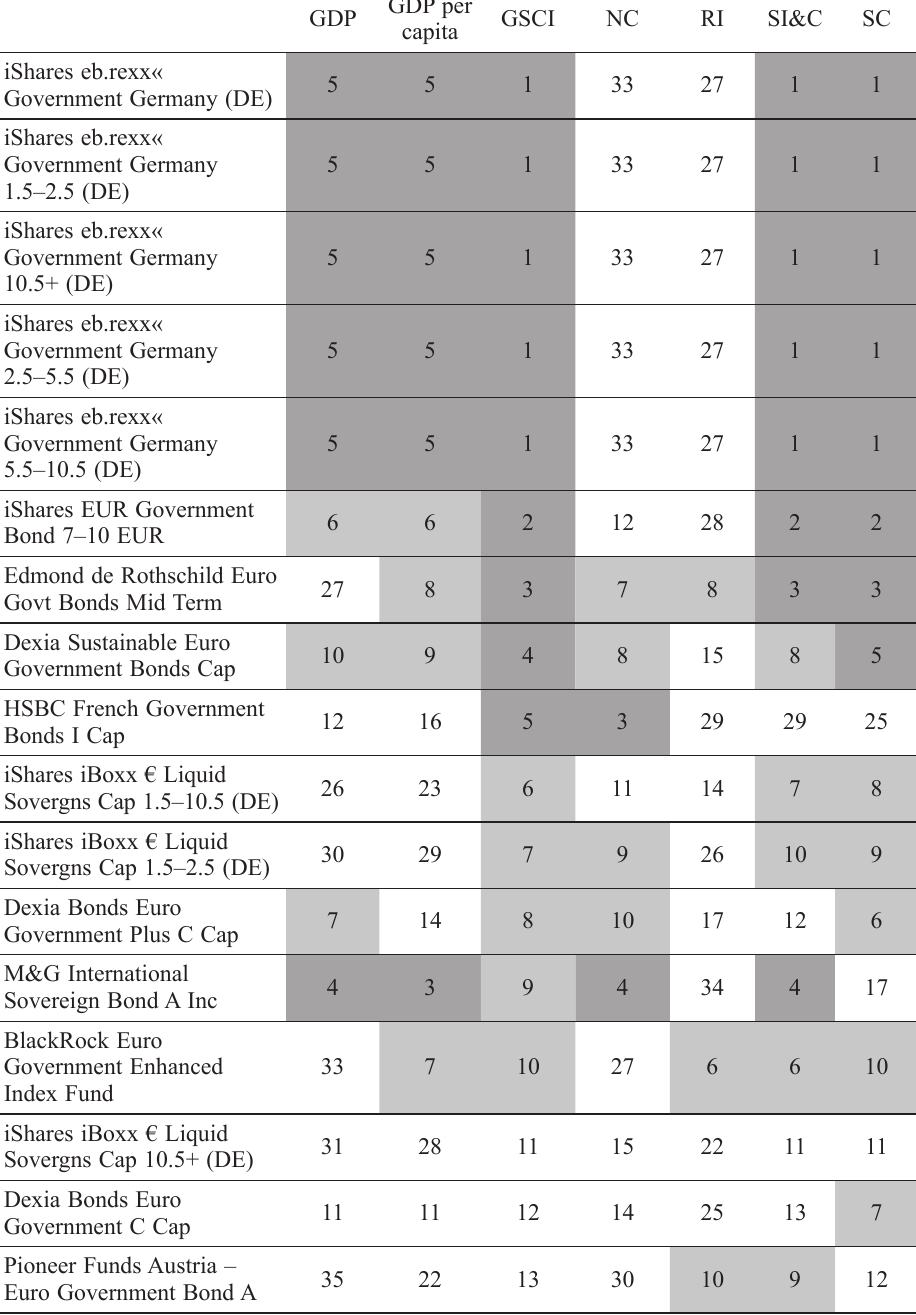
Table 2. Fund ranks on sustainability indexes and on